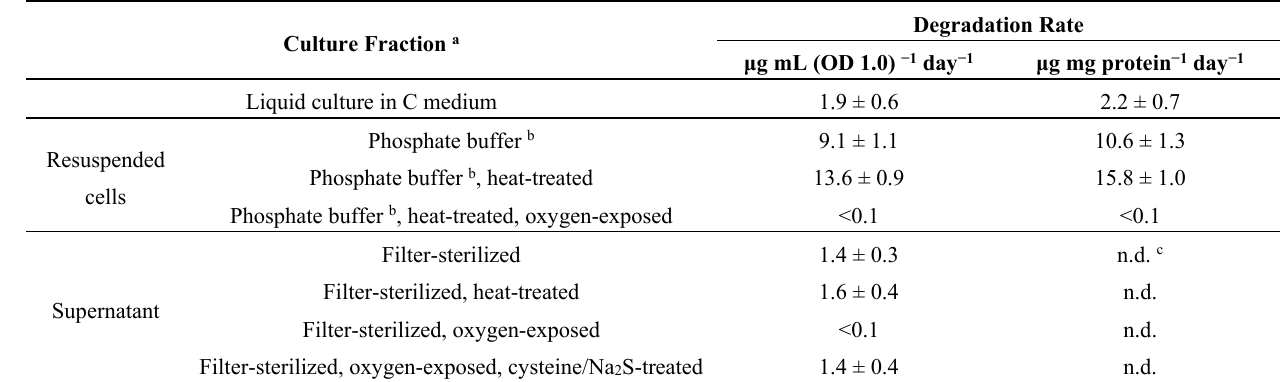
Table 2. Degradation of CCl 4 by Pelosinus sp.